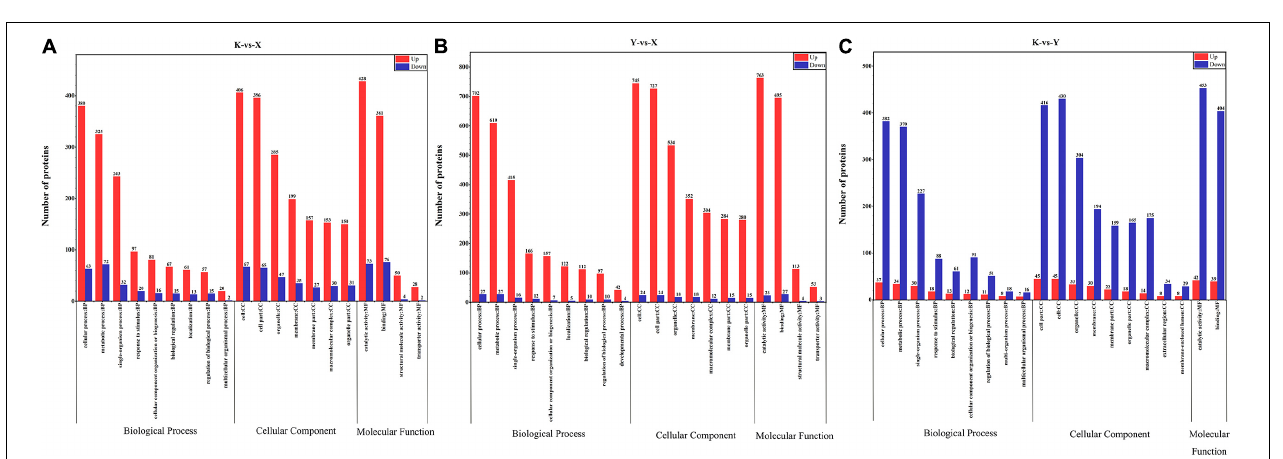
FIGURE 6 | Bioinformatics analysis of DAPs through GO in postharvest change processes in rhubarb. (A) Functional annotation of DAPs identified in shade-drying vs. fresh. (B) Smoke-drying vs. fresh. (C) Shade-drying vs. smoke-drying.